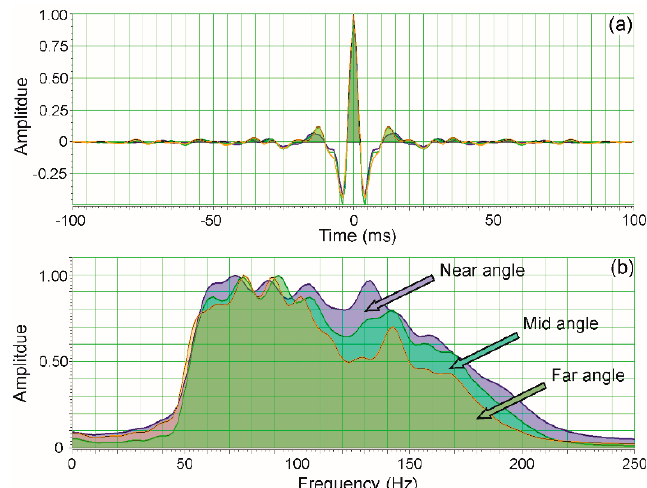
Figure 10. ( a ) Zero-phase wavelets estimated for different angle stacks (near, mid and far), which were used in inversion; ( b ) amplitude spectra of estimated angle wavelets. Note the changes in the frequency content of these wavelets.